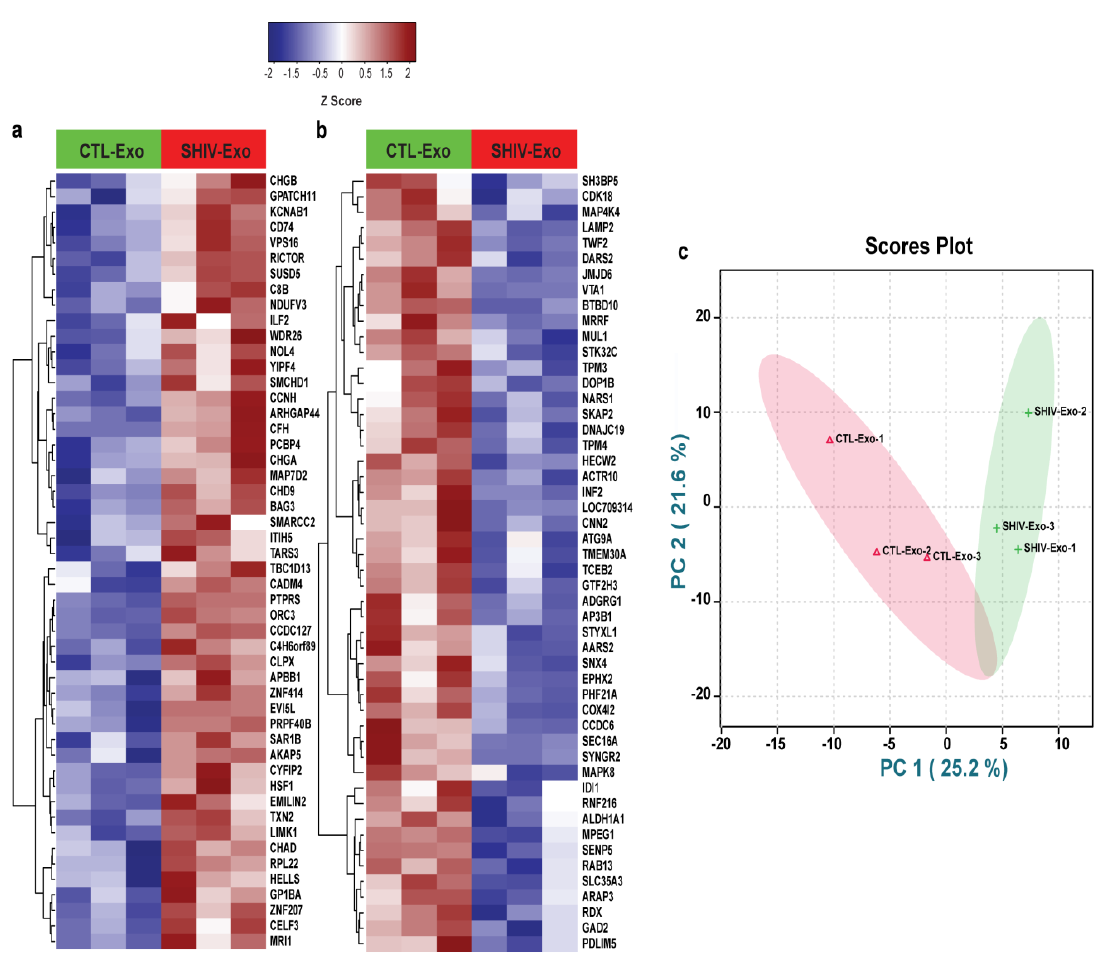
Figure 2. ( a , b ) A hierarchical cluster analysis of significant top 50 up-/down-regulated proteins in SHIV-Exo. Proteins were filtered based on p < 0.05. Median values were calculated for CTL-Exo and SHIV-Exo to calculate the ratio (SHIV-/CTL-Exo). The ratio was used to generate the list of top 50 up and down regulated proteins. Z scores were calculated for each significant protein, and then heatmaps were generated for all the significant proteins: top 50 upregulated and top 50 downregulated proteins using “Manhattan” clustering and “complete” linkage method. Protein coding gene names are presented here. ( c ) To test if the dataset samples were separated, we performed a principal component analysis (PCA) analysis on all protein expression data and as observed the CTL-Exo (in red) are clustered separately from the SHIV-Exo (in green). Unsupervised PCA plot is generated in R Studio by using median normalized and log 10 transformed data from each sample type. CTL-Exo: Plasma exosomes isolated from uninfected RM; SHIV-Exo: Plasma exosomes isolated from SHIV-infected RM.